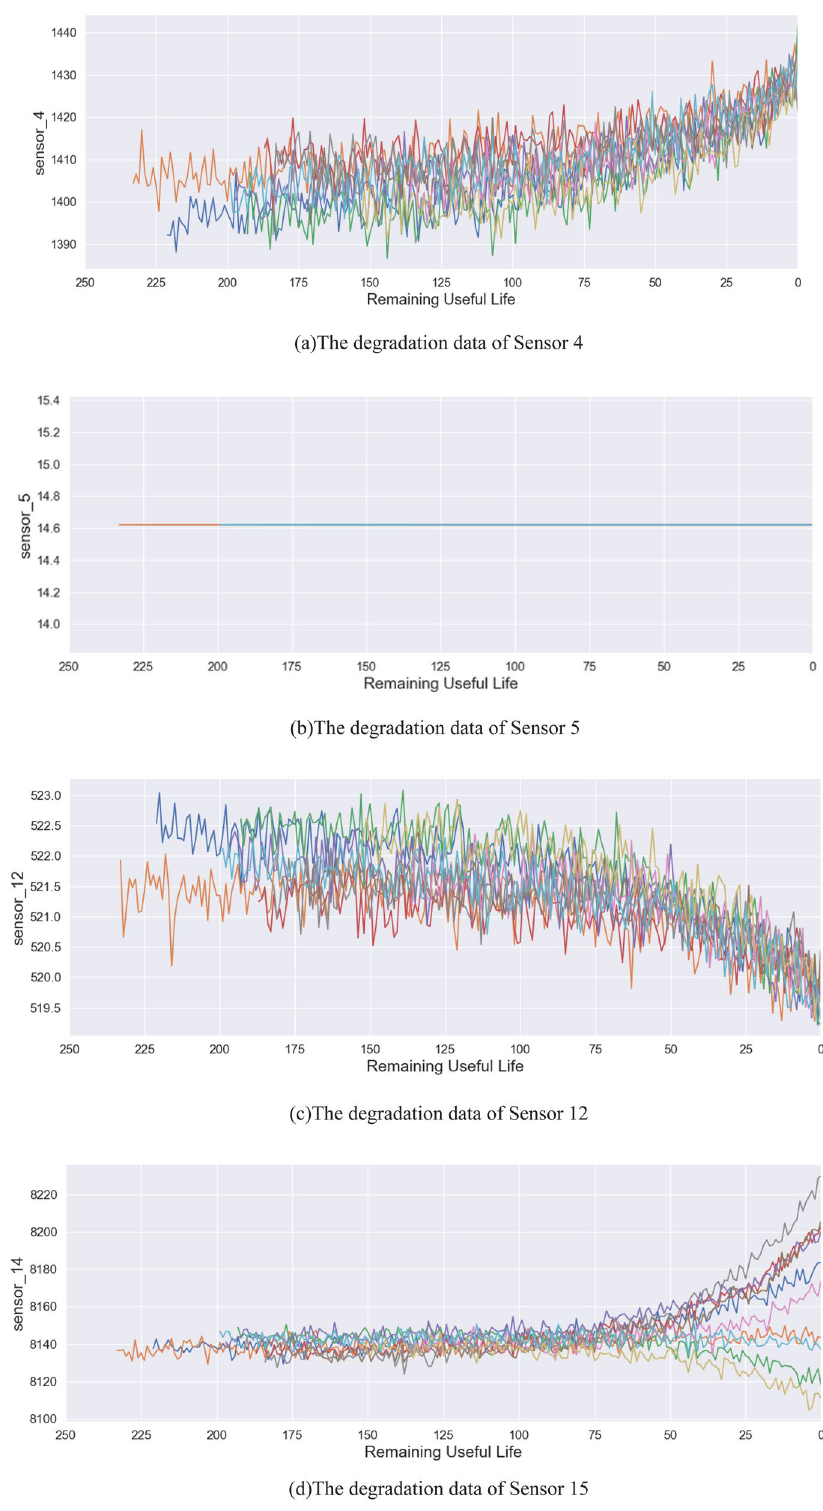
Figure 5. Degradation data of partial